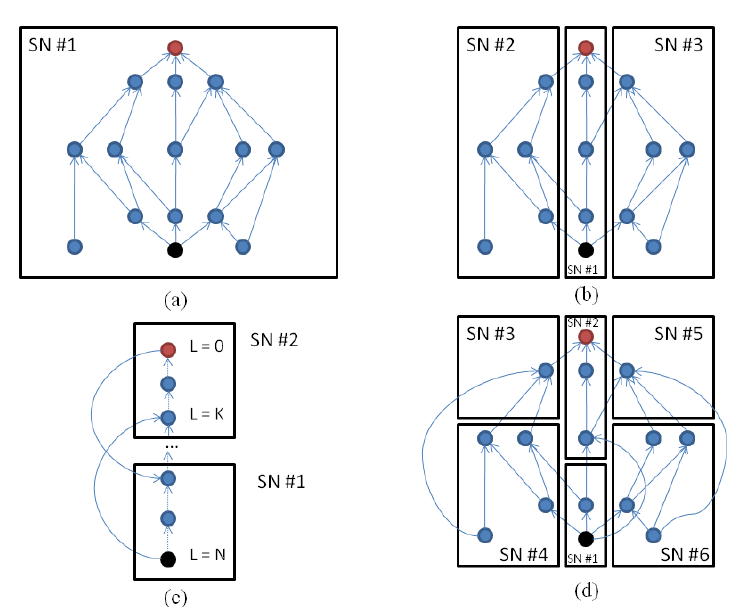
Four possible distributions for a semantic tree: ( a ) single SN; ( b ) branch partitioning; ( c ) vertical partitioning with forwards links; and ( d ) arbitrary combination of